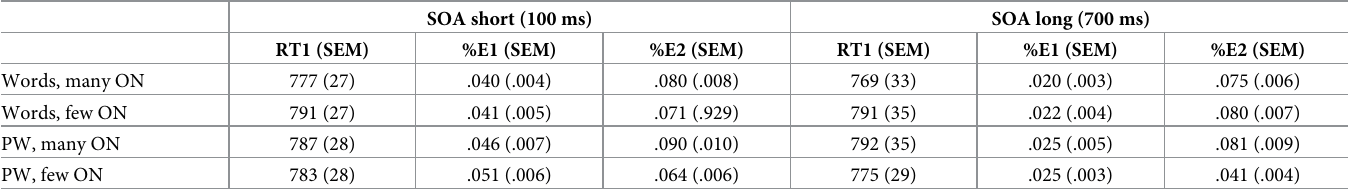
Table 1. Performance in the tone discrimination task (RT1 and %E1), and error rates in the lexical decision (%E2). SOA short (100